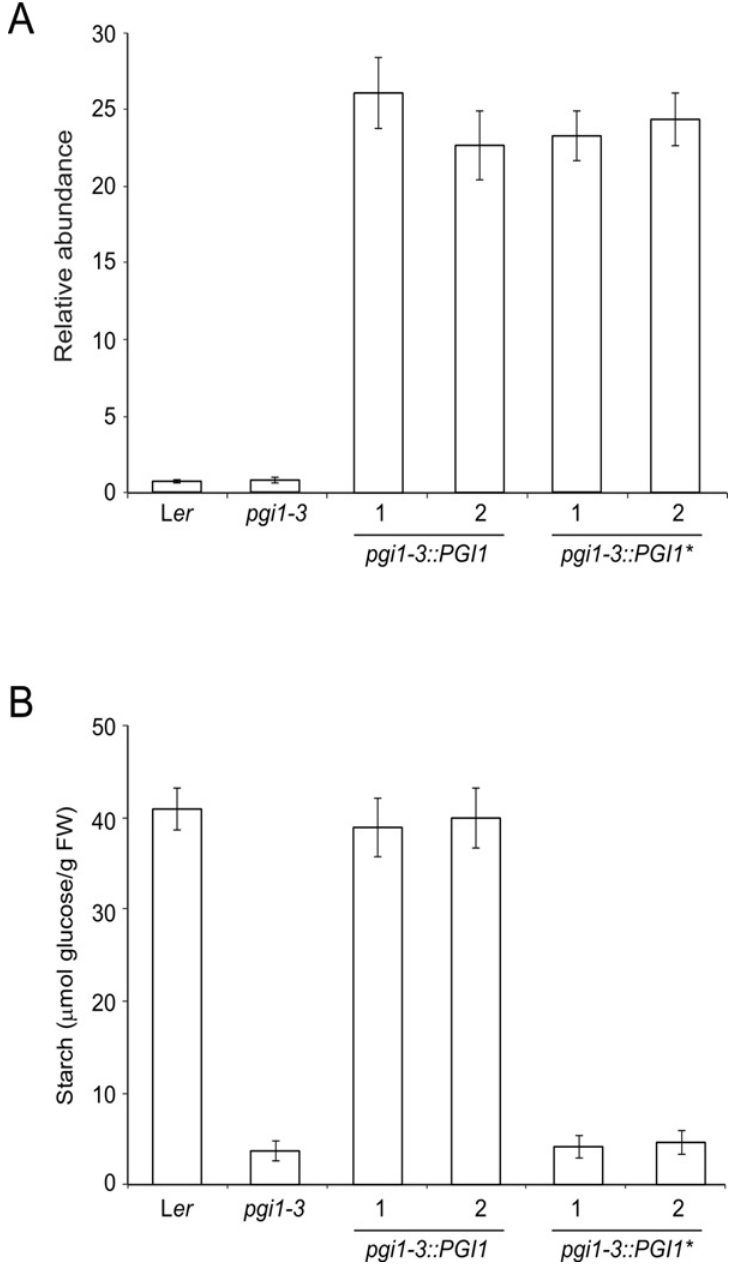
Fig 4. pgi1 – 3 is a pPGI null allele. (A) RT-PCR of PGI1 and (B) starch content in source leaves of WT (L er ), pgi1 – 3 and two independent lines each of pgi1 – 3 :: PGI1 and pgi1 – 3 :: PGI1 * . Plants were cultured on soil under LD conditions and leaves harvested from 30 DAG plants after 12 h of illumination. In “ B ” values represent the mean ± SE of determinations on five independent